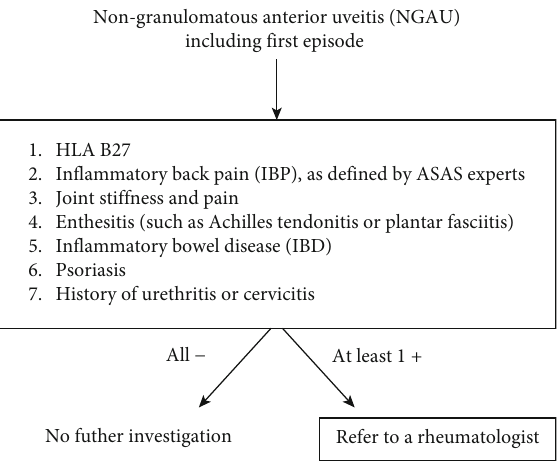
Figure 1: Reggio Emilia Uveitis Spondyloarthritis Interdisciplinary Approach (REUSIA) algorithm. Legend: HLA: human leukocyte antigen; ASAS: Assessment of SpondyloArthritis international